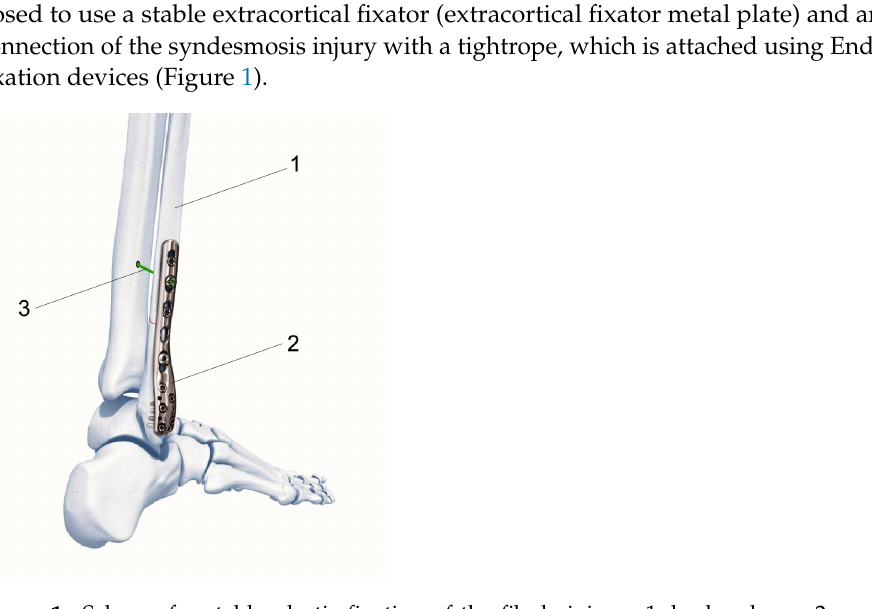
Figure 1. Scheme for stable–elastic fixation of the fibula injury: 1, broken bone; 2, metal plate, 3, elastic